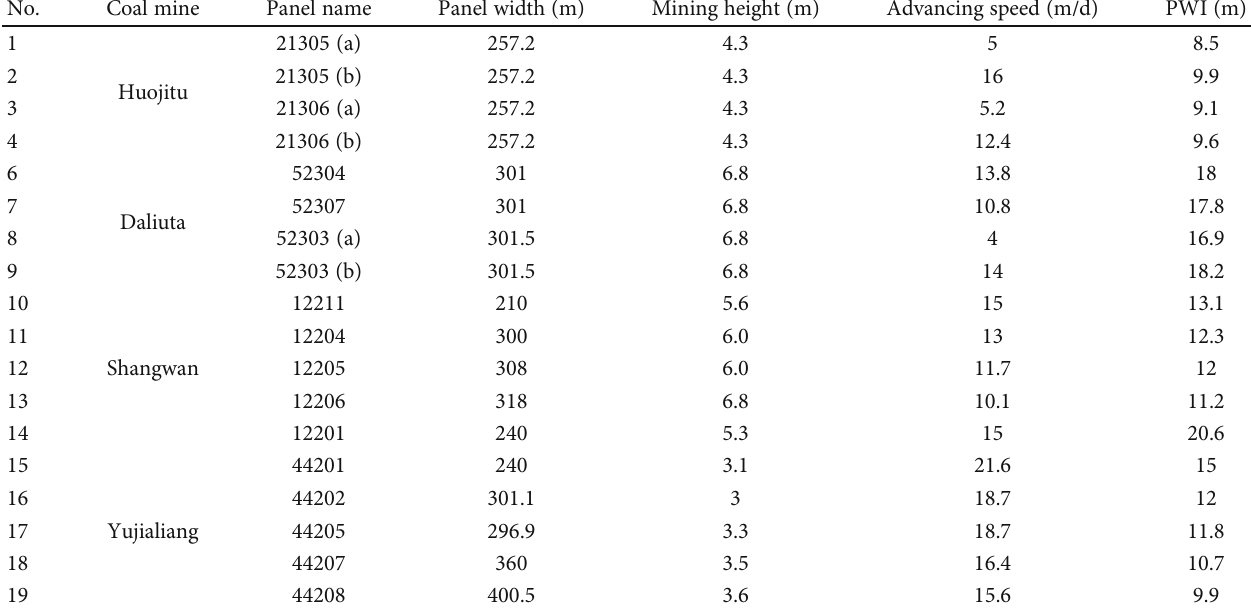
Table 1: Mining parameters and PWI of the longwall faces in the western mining